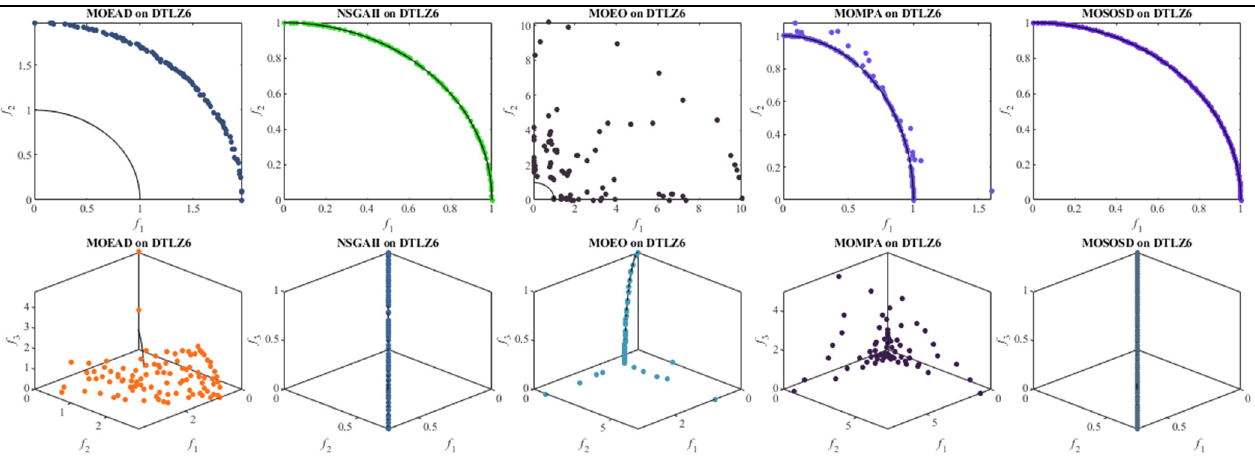
Figure 7. The Pareto front for DTLZ6 using various algorithms at 𝑀 = 2, 3 .